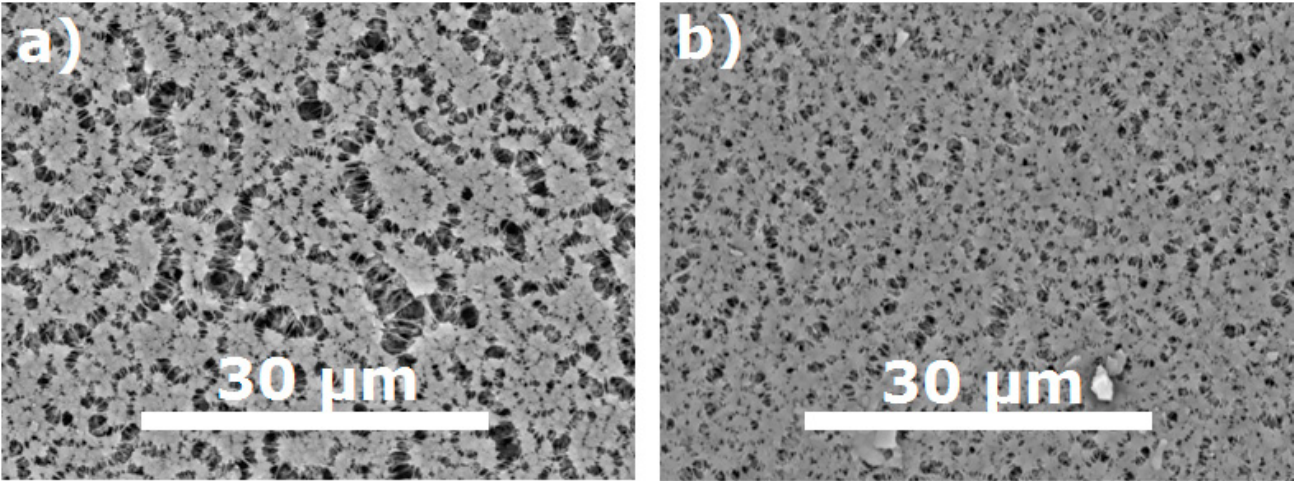
Figure 1. SEM images of MFFK-1 ( a ) and UFFK ( b ) surfaces.